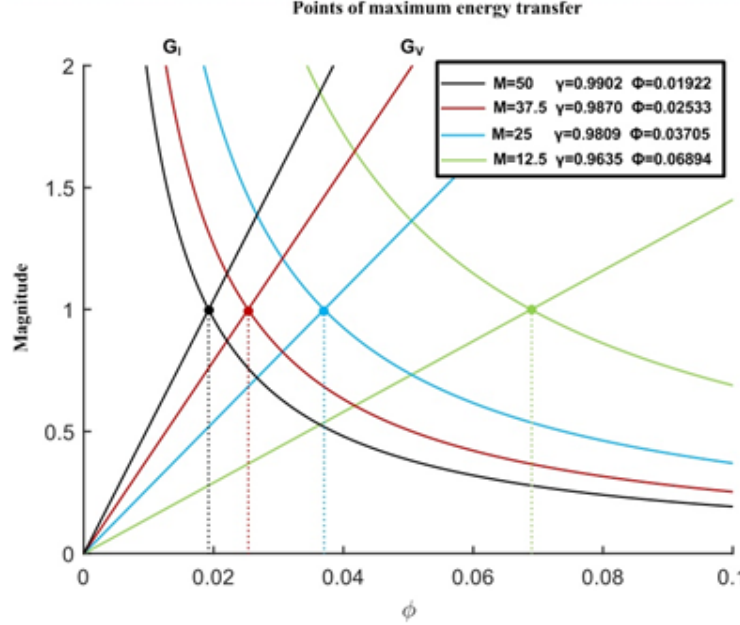
Figure 10. Points of maximum energy transfer.